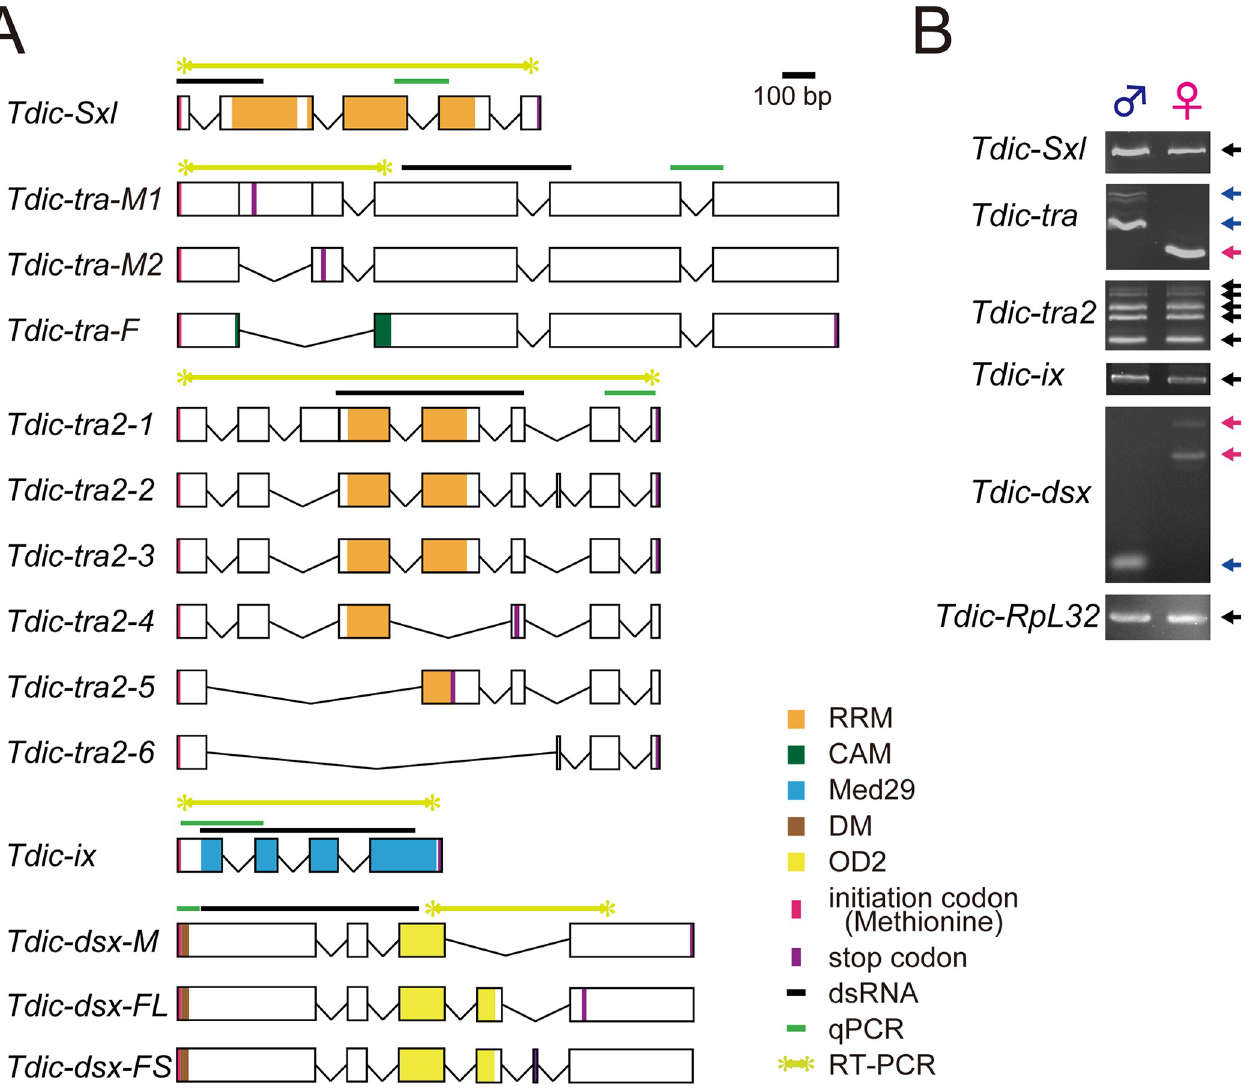
Fig 2. Schematic representation of putative exon–intron structures and sex-specific splicing patterns of the sex determination genes. (A) Schematics of putative exon-intron structures of the sex determination genes in T . dichotomus . Orange box, RRM (RNA binding motif); Green box, CAM (C, Ceratitis ; A, Apis ; M, Musca ) domain [34, 47], which is conserved in all tra orthologs identified in other insects except for those in Drosophila species and the sandfly ( Phlebotomus papatasi ) [48]; Light blue box, Med29 (mediator complex subunit 29) domain; Brown box, DM (Doublesex/Mab-3 DNA-binding) domain; Yellow box, OD2 (Oligomerization dmain 2); Black bars, template sequences for dsRNA synthesis; Green bars, the amplified regions in qRT-PCR analysis; Light green bars, the amplified region to test sex-specific splicing variants; Magenta lines, translation start sites; Purple lines, stop codons. (B) Evaluation of expression and sex-specific splicing patterns in the sex determination genes in male and female prepupal head horn primordia. Template cDNAs were derived from prepupal horn primordia at 72 h APF. Tdic-RpL32 was used as an internal control for RT-PCR. Blue arrows, PCR products with male specific splicing variants; Magenta arrows, PCR products with female specific splicing variants; Black arrows, PCR products amplified in both sexes.